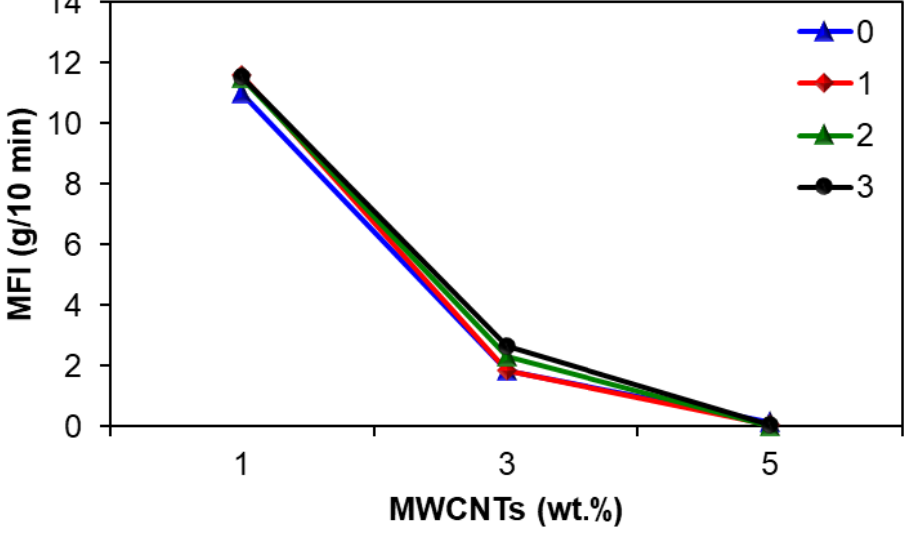
Figure 4. Effect of recycling on the MFI of EVA/MWCNT nanocomposites.